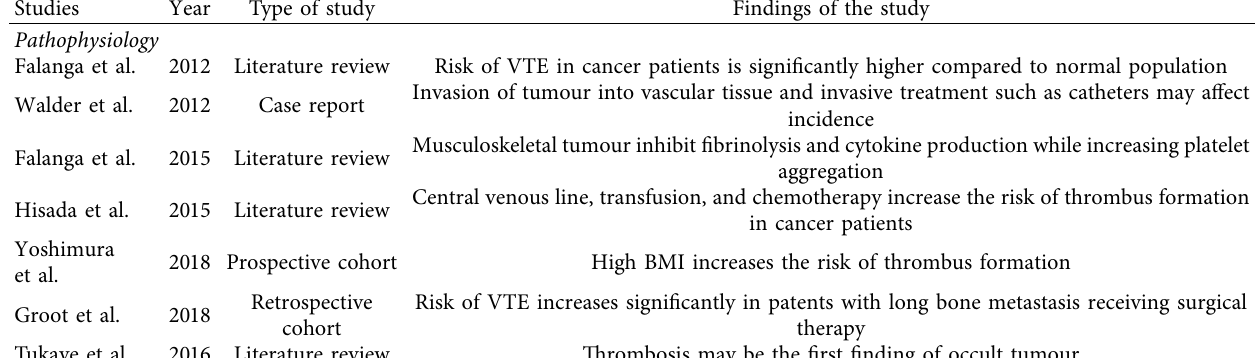
Table 1: List literatures